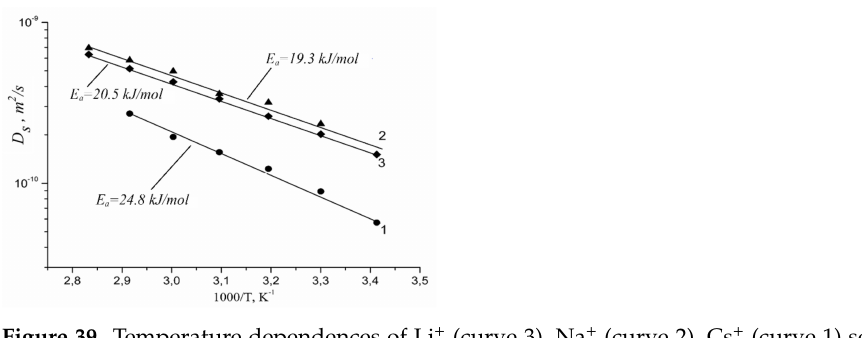
Figure 39. Temperature dependences of Li + (curve 3), Na + (curve 2), Cs + (curve 1) self-diffusion coefficients in Li + , Na + , Cs + Nafion 117 membrane ionic forms. RH = 98%. Reprinted with permission from [109]. Copyright 2021 Elsevier.